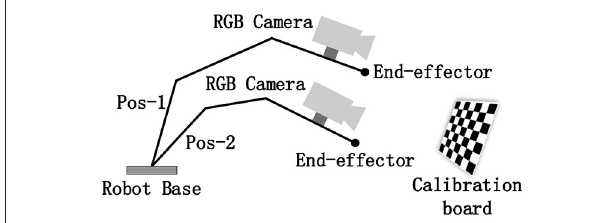
FIGURE 1 | Schematic of the hand–eye calibration problem.